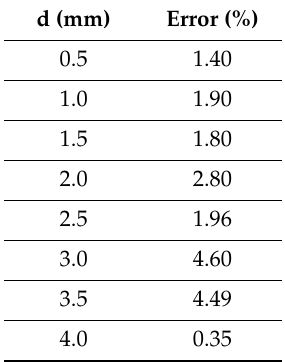
Figure 14. Measurement accuracy error at high temperatures. Table 6. Measurement error at high